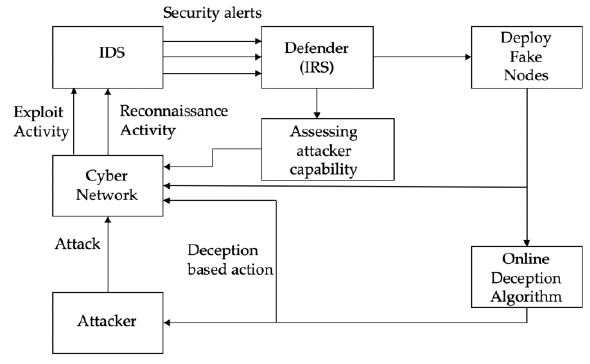
Figure 1. Dynamic security